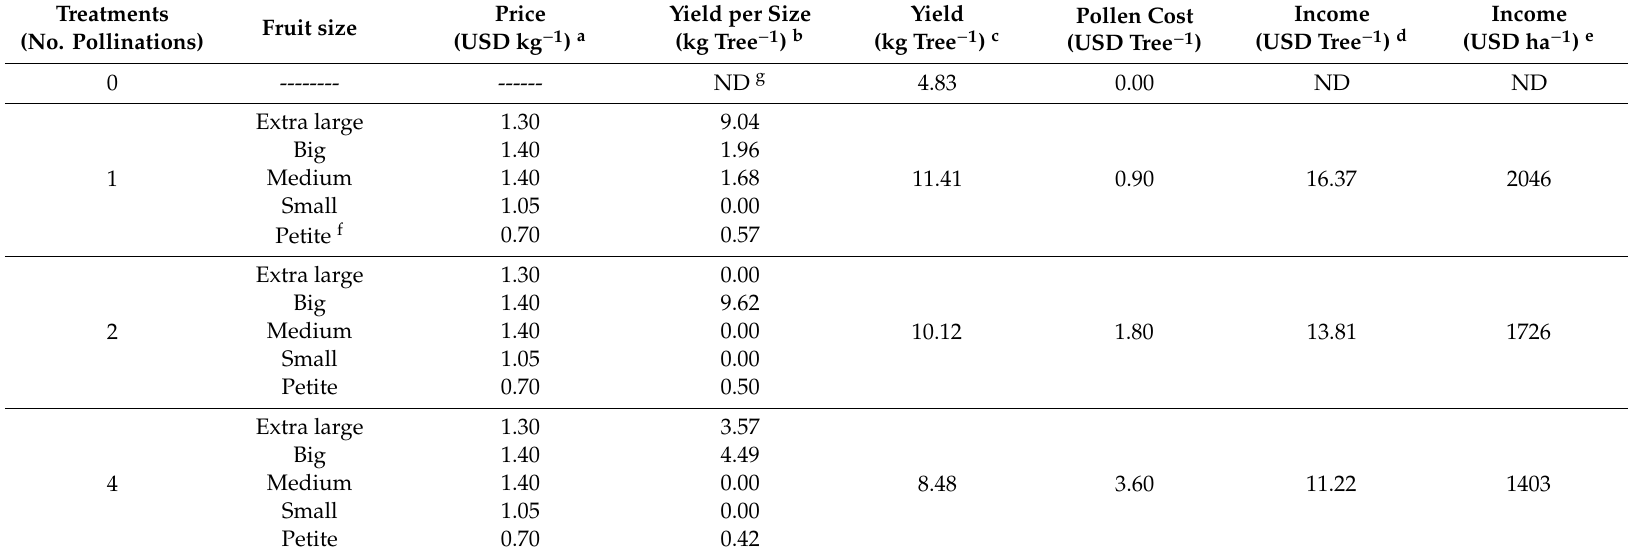
Table 3. E ff ects of di ff erent frequencies of artificial pollination on yield and income in light-flowering ‘Manzanillo’ trees. Year 2018.